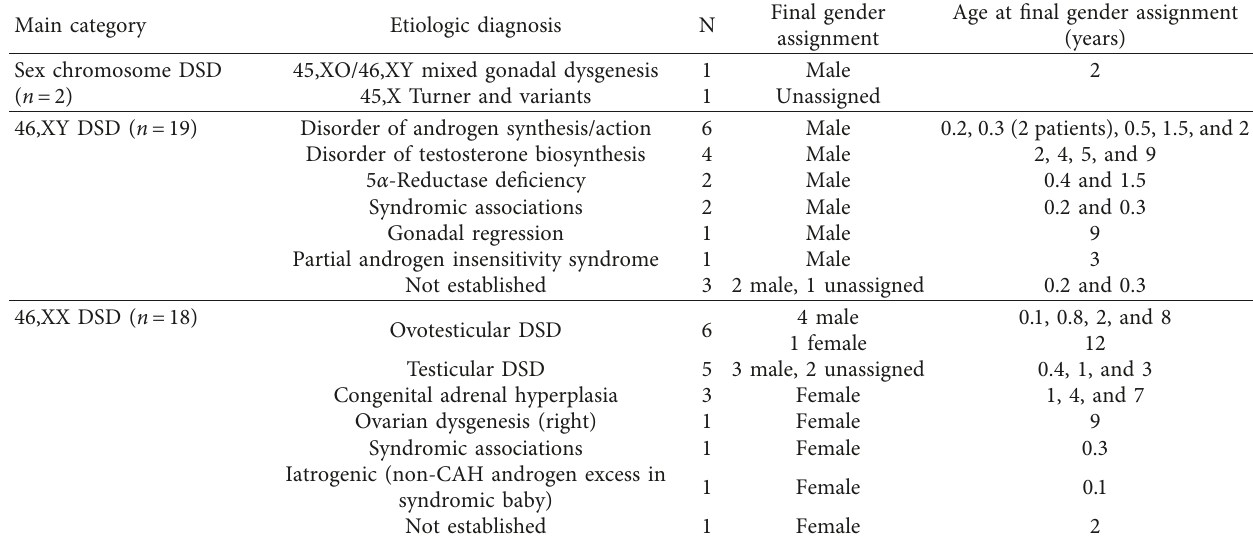
Figure 2: Karyotypes. Table 1: Etiological classification among karyotyped patients ( n �